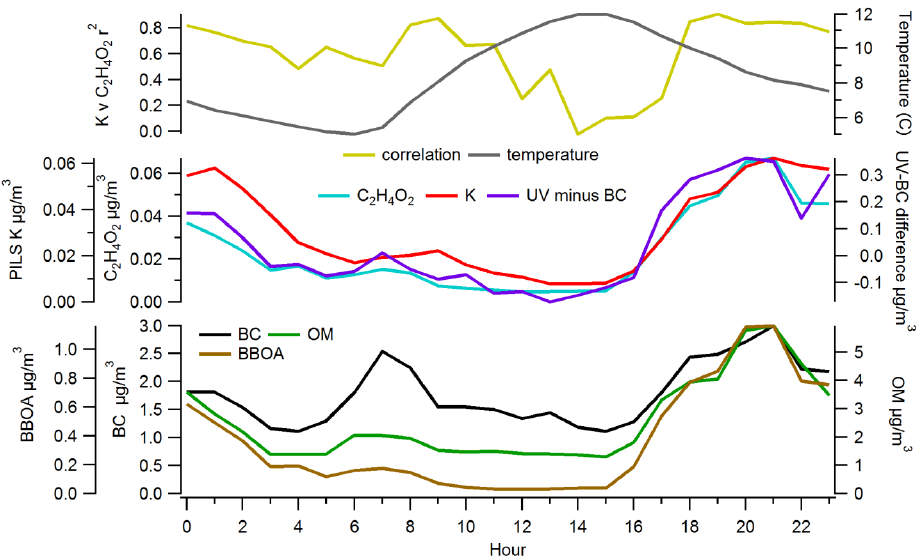
Figure 2. Average concentration by hour (LST) for Aethalometer BC, AMS OM, PMF-BBOA, UV-BC difference, PILS K + , and AMS C 2 H 4 O 2+ (all units µg/m 3 ), plus correlation ( r 2 ) by hour of PILS K + vs. AMS C 2 H 4 O 2+ and temperature (degrees C).